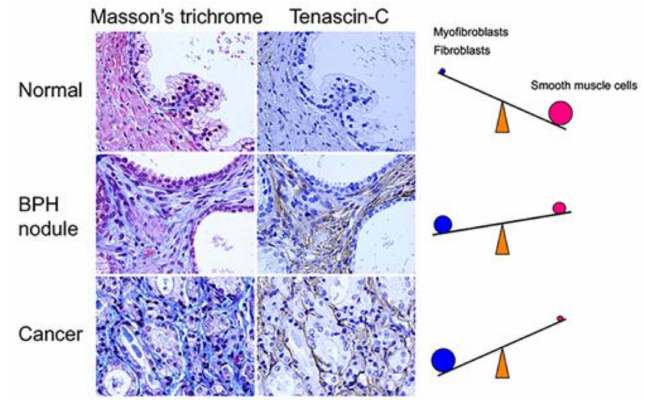
Figure 2. Stromal changes associated with proliferative diseases of the aging human prostate. Surgical tissue specimens obtained from patients with BPH or PCa were histologically stained with Masson’s trichrome and immunostained with an anti-tenascin-C antibody. Masson’s trichrome stained smooth muscle cells pink and fibroblasts/myofibroblasts blue. BPH: benign prostatic hyperplasia; PCa: prostate cancer. Magnification 400 ×